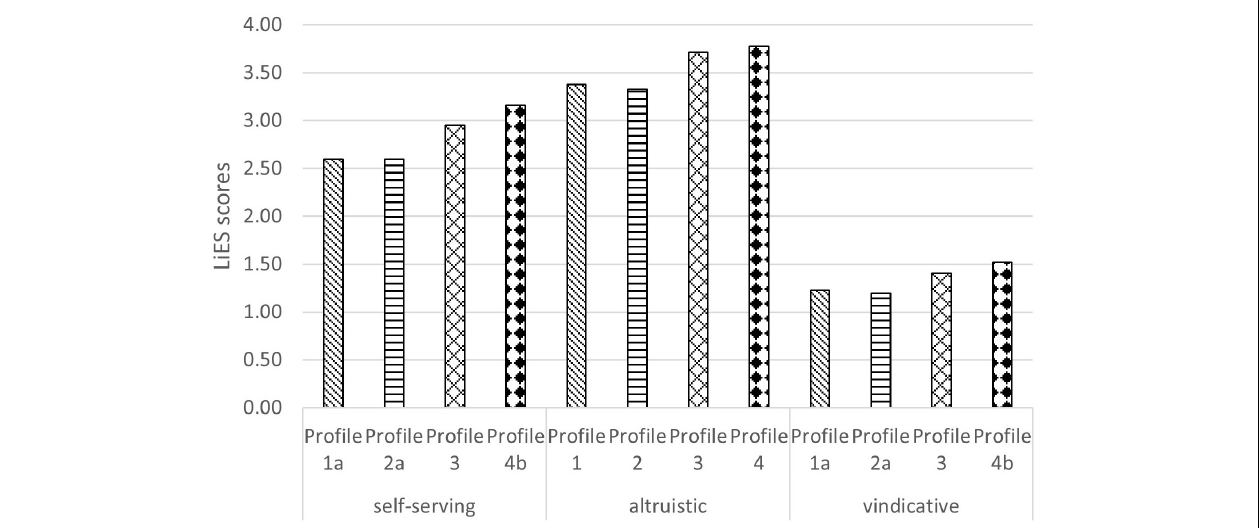
FIGURE 2 | Profiles comparisons of the scores of the three LiES dimensions: self-serving lies, altruistic lies, vindicative lies. Different superscripts indicate a difference with p < 0.05. E.g., for self-serving lies Profile 1 and Profile 2 differ from Profile 4 but not from each other nor from Profile 3. The higher the score, the higher the tendency to tell specific types of lies (e.g.,